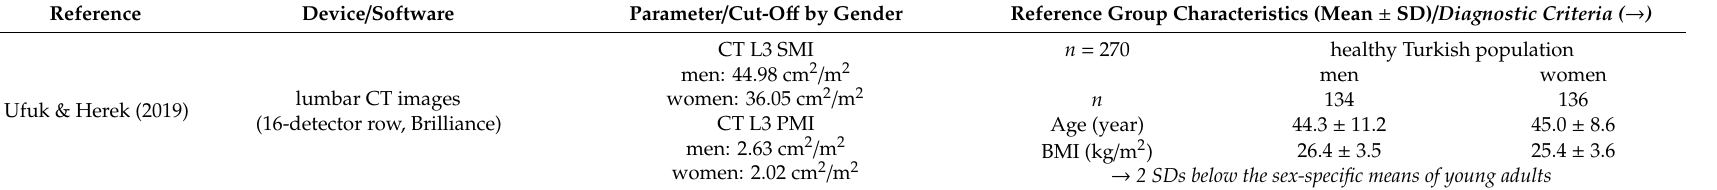
Table 3. Cut-o ff values and diagnostic criteria of a low muscle mass using computed tomography